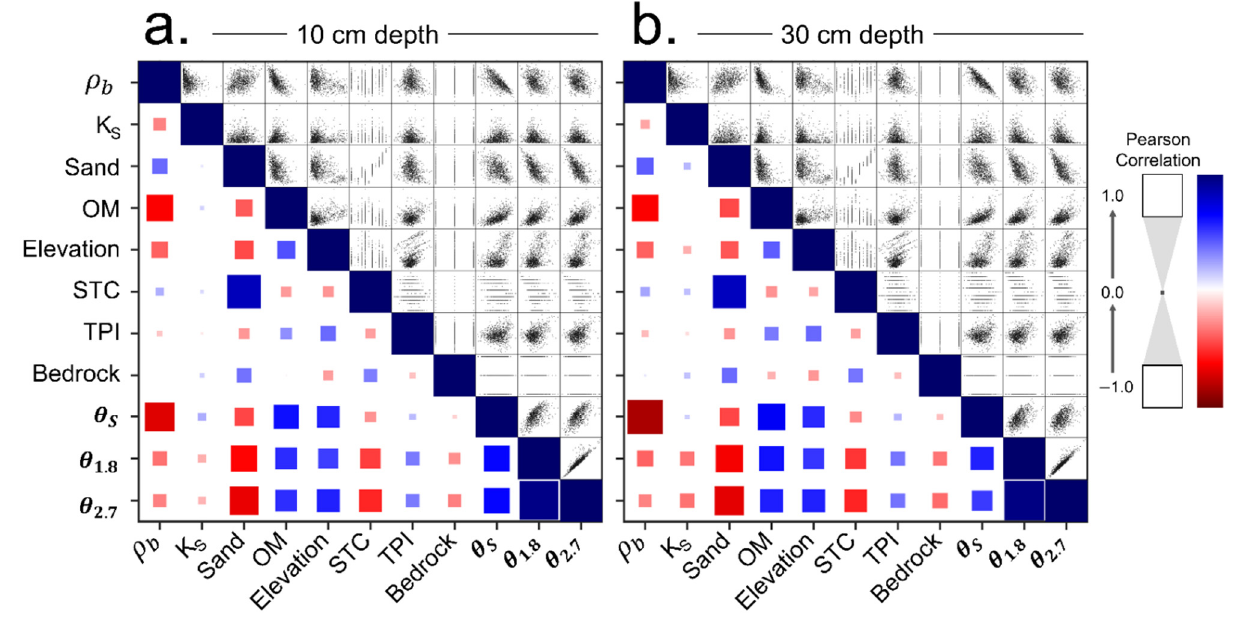
Figure 4. Correlation matrix of 8 highly important variables and SWHCs.